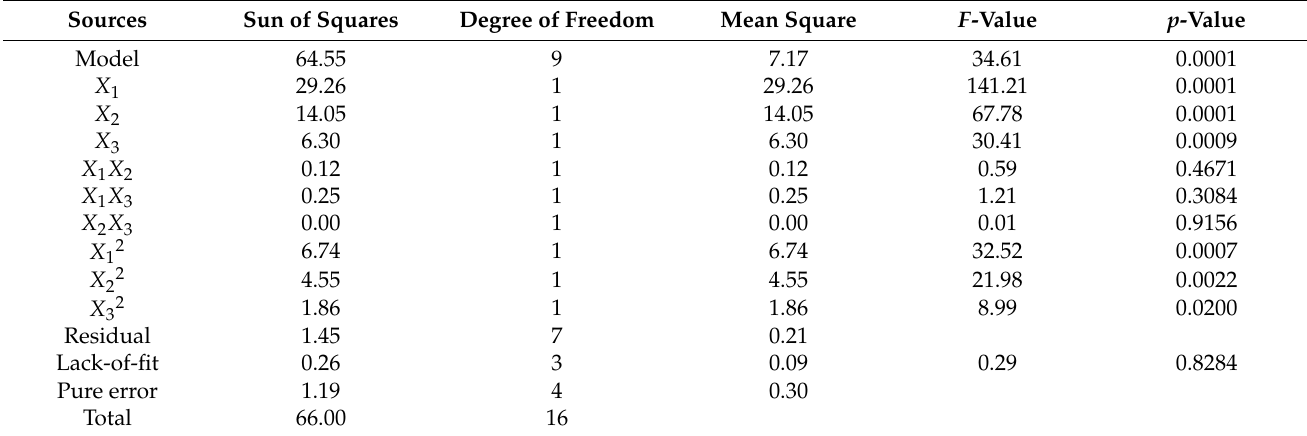
Table 6. ANOVA of the harvesting rate of unripe